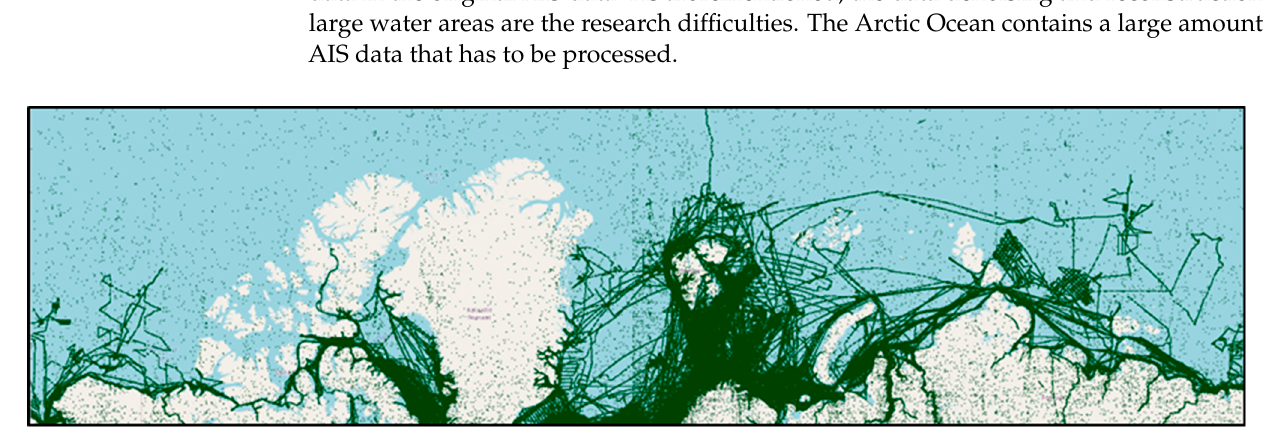
. Figure 4. The raw AIS data in the Strait of Dover. All numerical experiments were performed using 64 ‐ bit Windows 10 on a 2.4 GHz Intel Core i5 9300H CPU, NVIDIA GeForce GTX 1650 GPU with 8 GB memory. The pro ‐ posed algorithms were programmed in Python 3.9. The flowchart of experiments is shown in Figure 5.